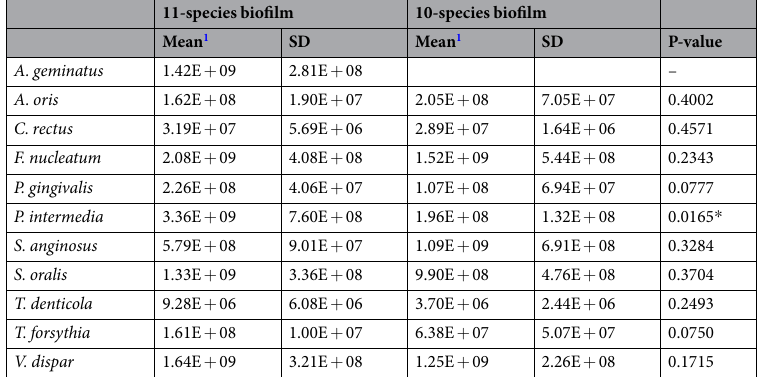
Table 1. Quantitative composition of the 11-species or 10-species biofilm after 64 h cultivation. 1 Quantification was performed by qPCR for each species, per HA disc. The data is expressed as the bacterial mean counts ± standard deviation (SD) from three biological replicates. Student t test: * p-value < 0.05.